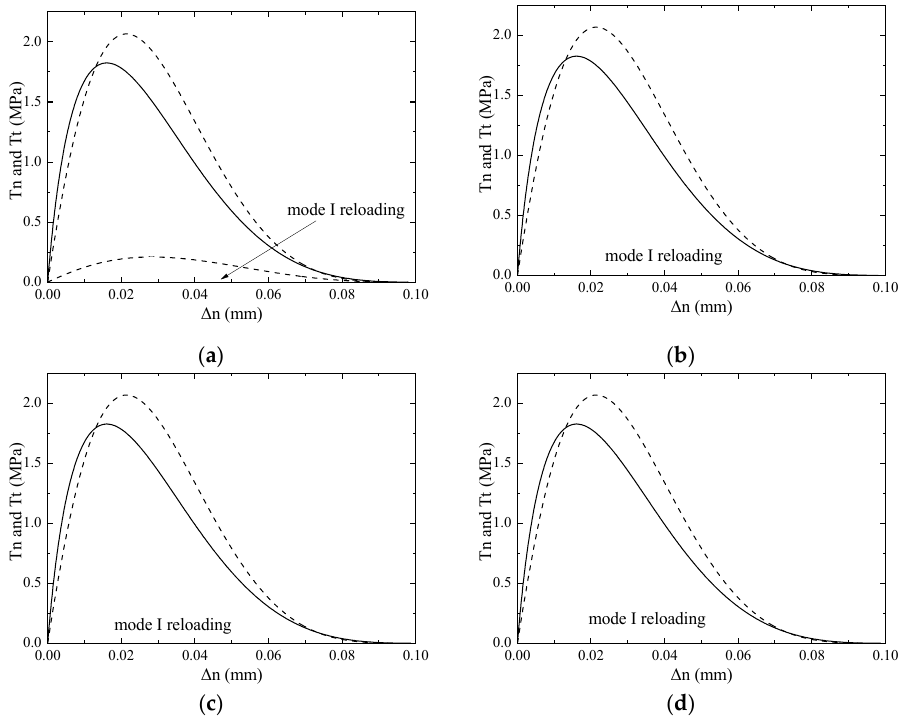
Figure 18. Variations of the traction components T n (solid lines) and T t (dashed lines) during the process of proportional loading/unloading and mode I reloading, for a proportional loading amplitude of Δ = 0.098 mm ( a , b ); or Δ = 0.099 mm ( c , d ). Model (i) ( a,c ); model (ii) and model (iii) ( b,d ).